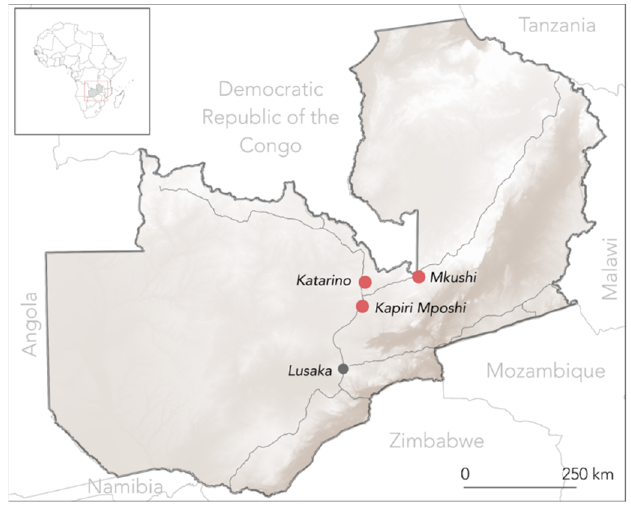
Figure 1. Location map of forest reserves of Zambia.